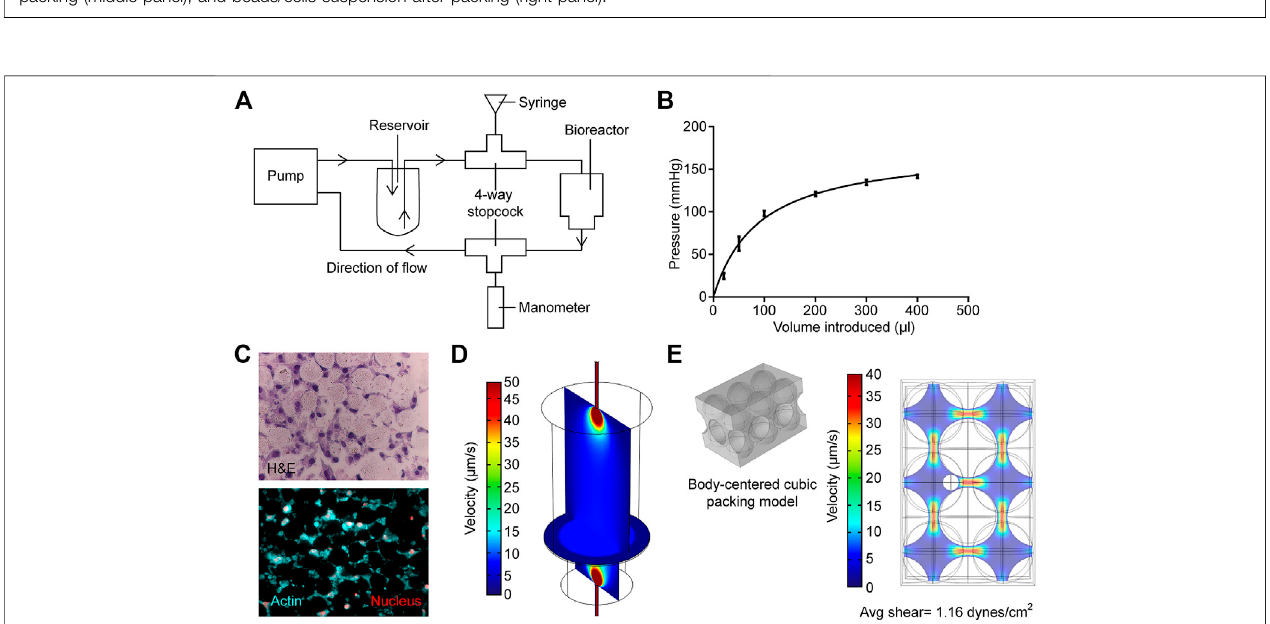
FIGURE 2 | Measurement and modeling of system pressure and fl uid shear stress. (A) Schematic of how system is modi fi ed to measure and modulate internal pressure. (B) Measured internal pressure in response to the additional fl uid volume introduced. (C) H&E sections (upper panel) and actin staining (bottom panel) of the MLO-Y4murineosteocyte-likecell/beaddiscstructure (D) Renderedverticalandhorizontalslicesshowingmedium fl owpro fi leswithintheprimarybioreactormodel. (E) Left; pro fi le of hard-packed HA/TCP spheres. Right; rendering of the medium velocity pro fi le around the modeled osteocyte, larger spheres are HA/TCP